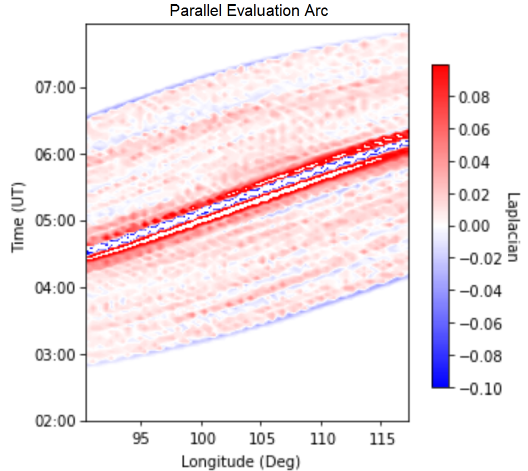
Figure 17. Contour/color-map plot of the Laplacian of the solar EUV irradiance level at 100km altitude as a function of time and longitude along the parallel evaluation arc, within a magnified time interval around the solar eclipse on 26 December